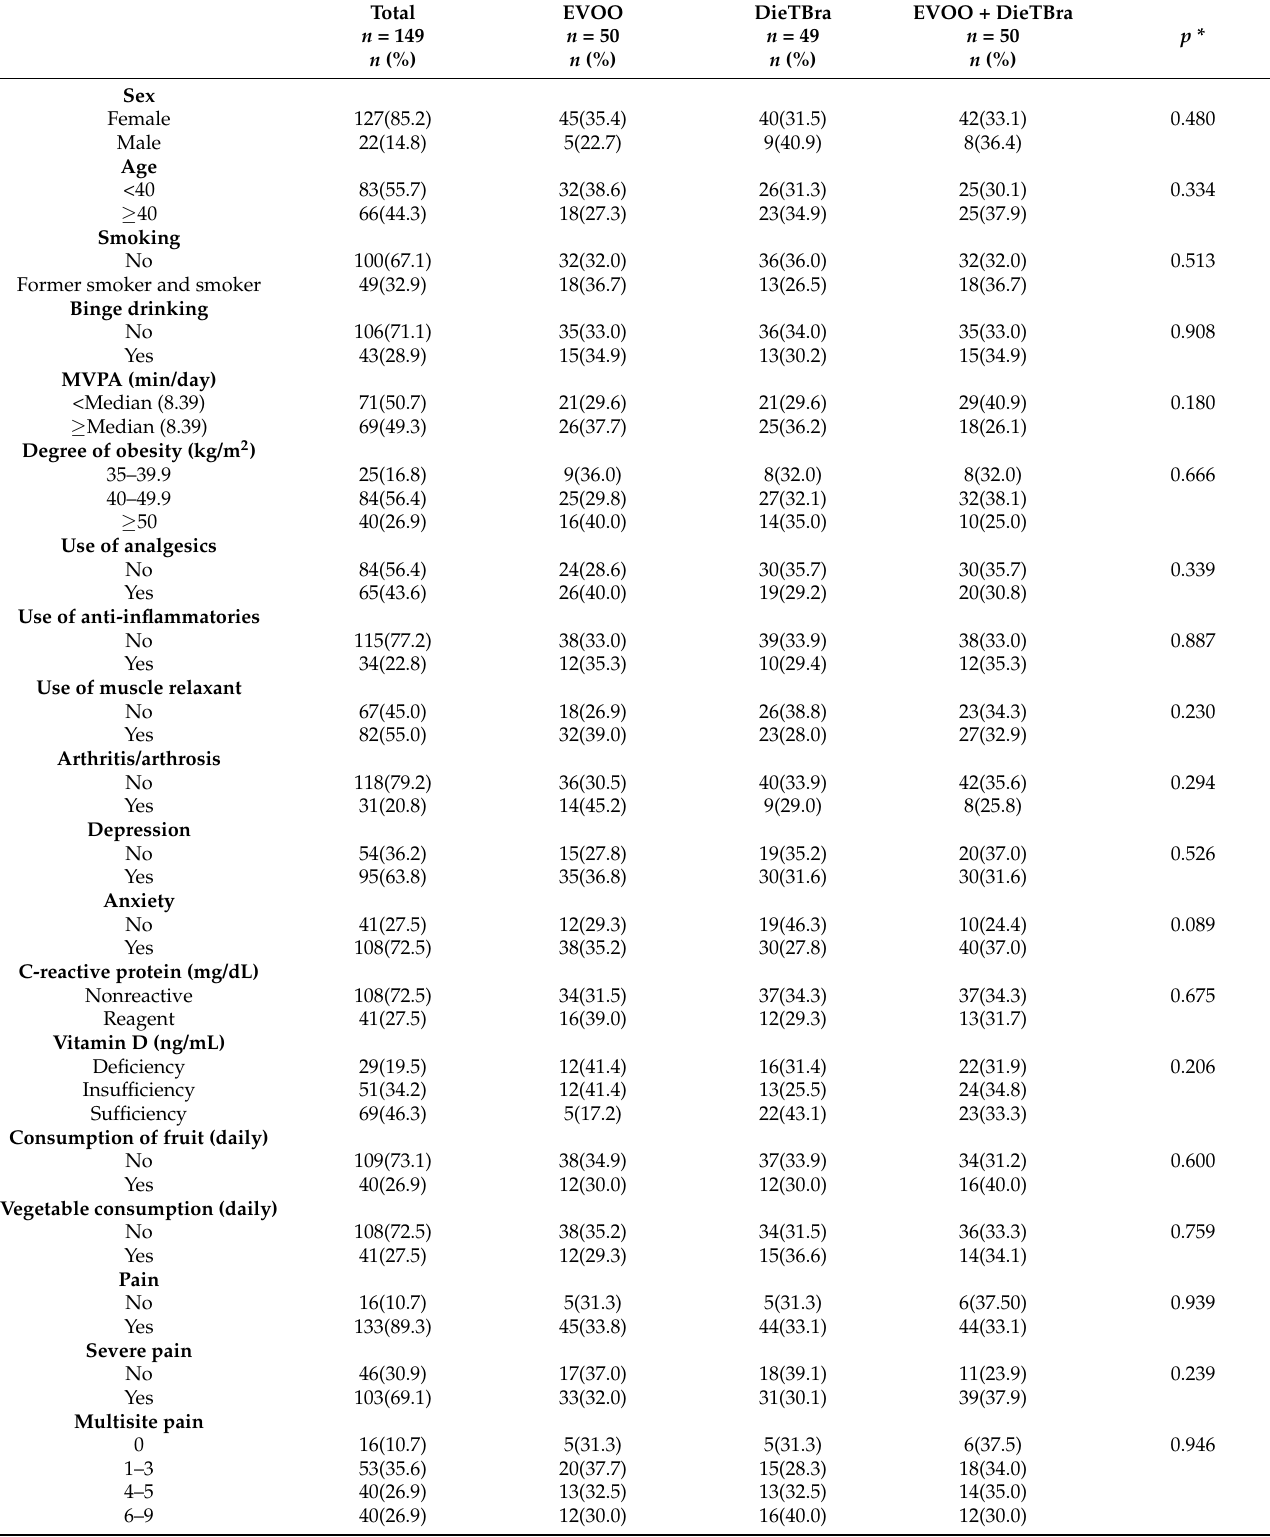
Table 1. Demographic characteristics, lifestyle, clinical conditions, food consumption, and musculoskeletal pain of the study